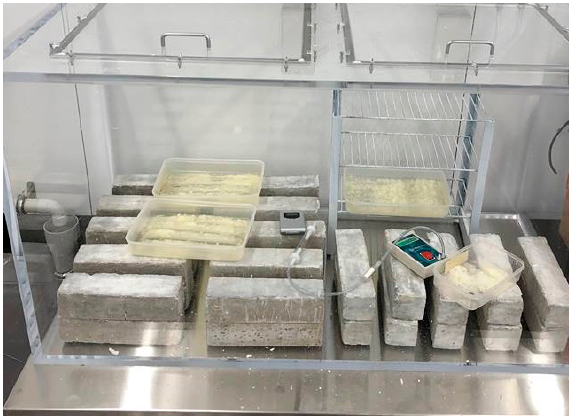
Figure 2. Overview of carbonation chamber.